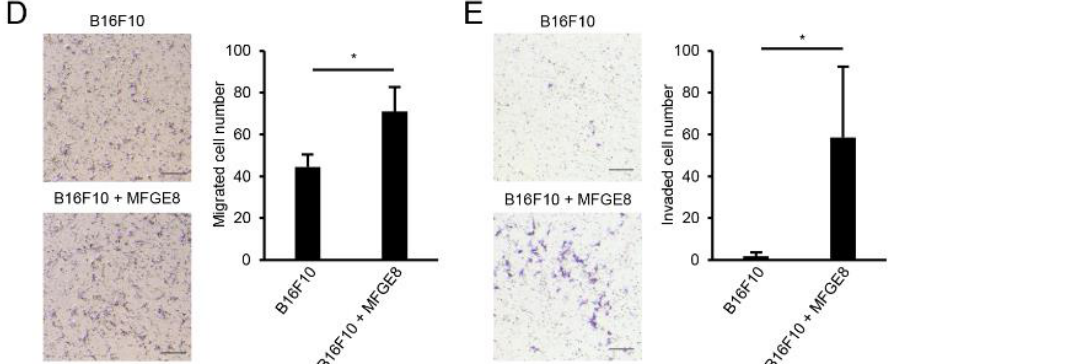
Figure 5. MFGE8 secreted by MDSCs affects B16F10 melanoma transmigration and invasion. ( A ) Schematic figure of co-culture experiments with MDSCs and B16F10 melanoma cells. ( B ) Co-culture of MDSCs and B16F10 melanoma cells. B16F10 cells were labeled with CellTrace Violet before co-culture. ( C ) Co-culture of MDSCs and B16F10 melanoma cells with MFGE8 neutralization. B16F10 cells were labeled with CellTrace Violet before co-culture. ( D ) Transmigration of B16F10 melanoma cells with MFGE8 treatment. ( E ) Invasion assay of B16F10 melanoma cells with MFGE8 treatment. Scale bars, 500 µm. Data are expressed as the mean ± SD. * p < 0.05, ** p < 0.01, and *** p < 0.001 by two-tailed t -test.